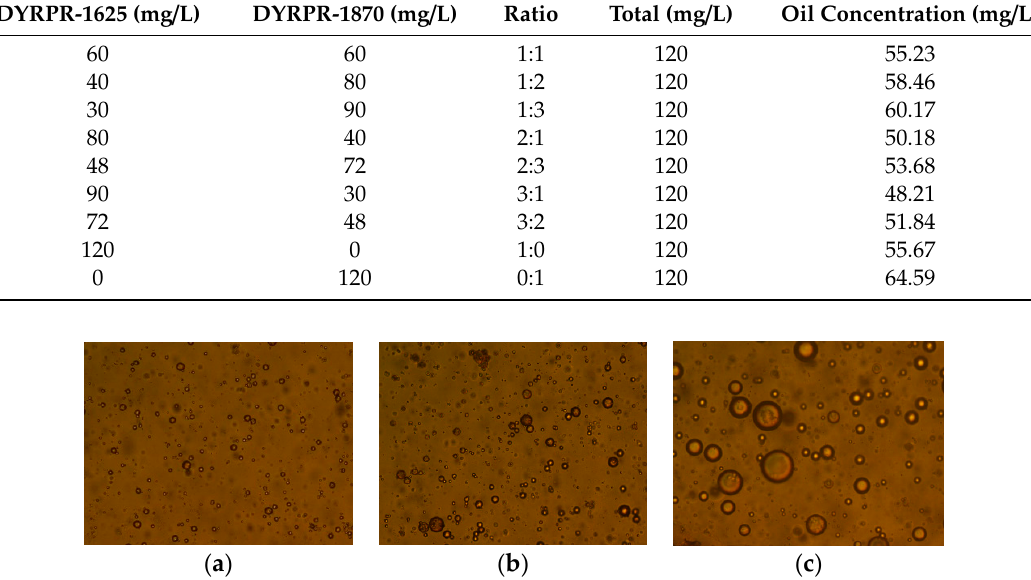
Table 3. Di ff erent combination schemes and demulsifying e ff ects of compound demulsifiers. Table 3. Different combination schemes and demulsifying effects of compound demulsifiers. DYRPR-1625 (mg / L) DYRPR-1625 (mg/L)